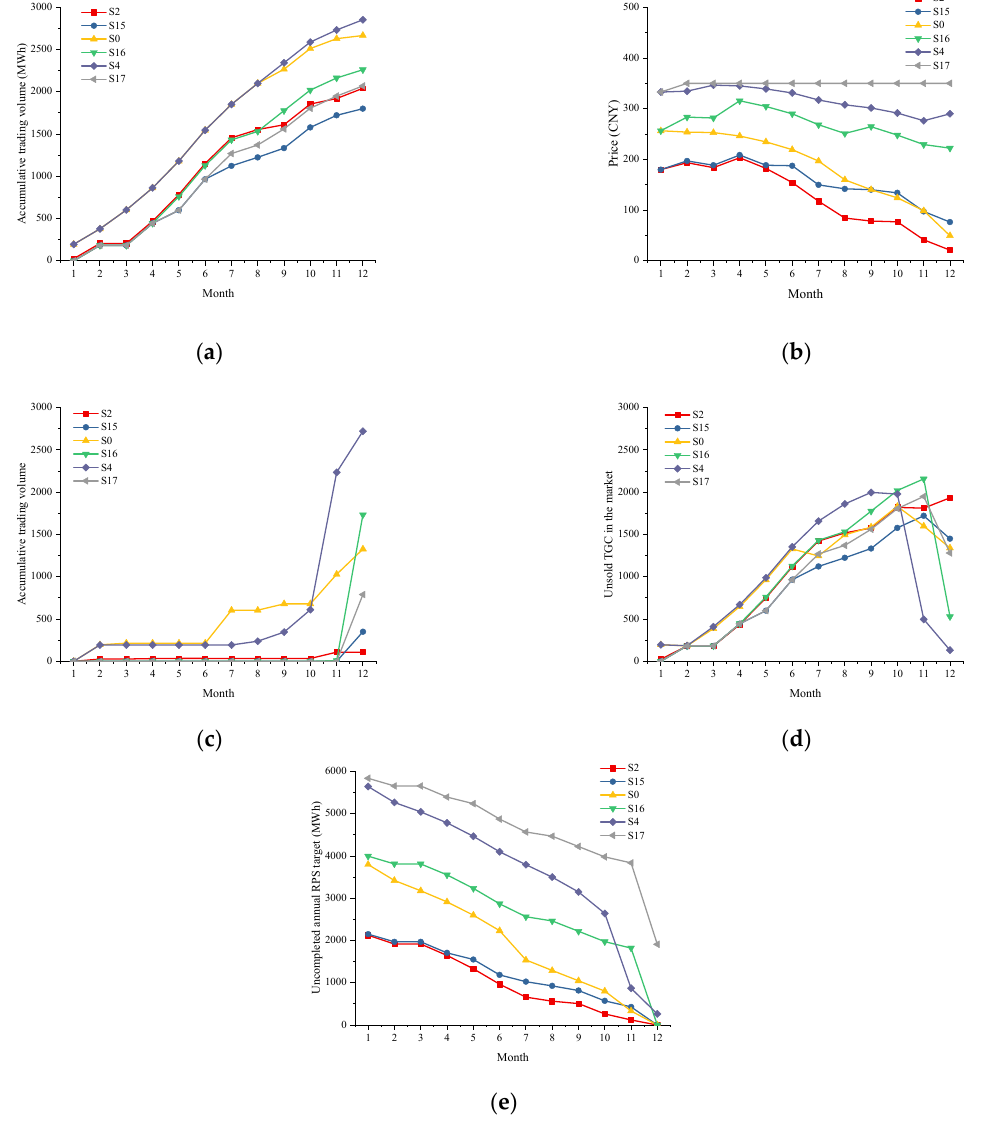
Figure 11. Trends of decision-making and market performance under different discount factors and RPS weights. ( a ) Accumulative renewable-power trading volume. ( b ) TGC price. ( c ) Accumulative TGC trading volume. ( d ) Accumulative unsold TGCs. ( e ) RPS target completion.